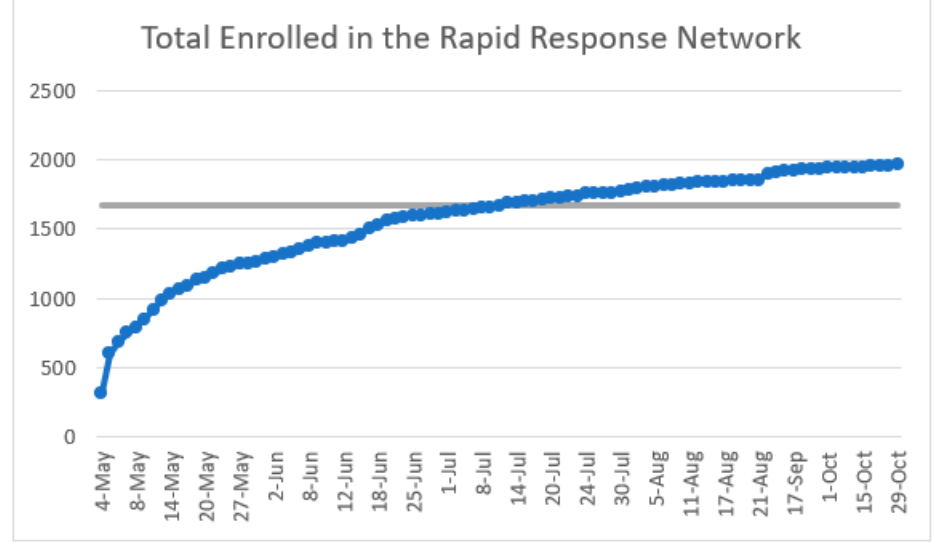
Figure 2. Total participant enrollment in the RRN (May–October 2020).